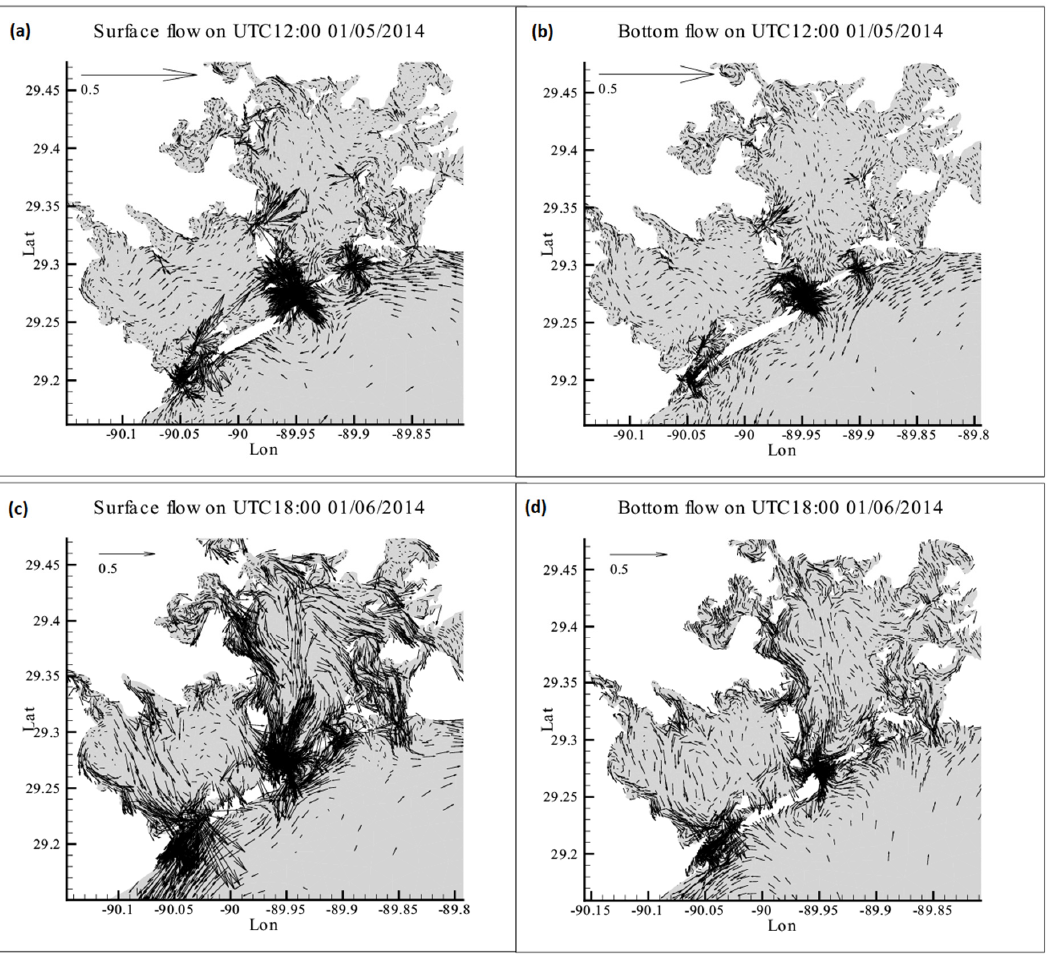
Figure 6. Surface and bottom flows influenced by the cold front event in January 2014. ( a , b ) are surface and bottom flows on 1200 UTC, 5 January 2014; ( c , d ) are surface and bottom flows on 1800 UTC, 1 January